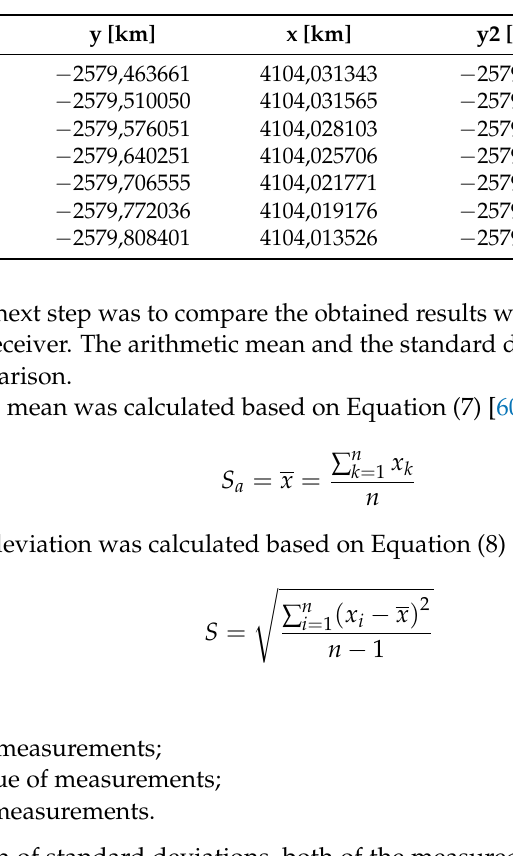
Table 2. x2, y2 coordinates with assigned